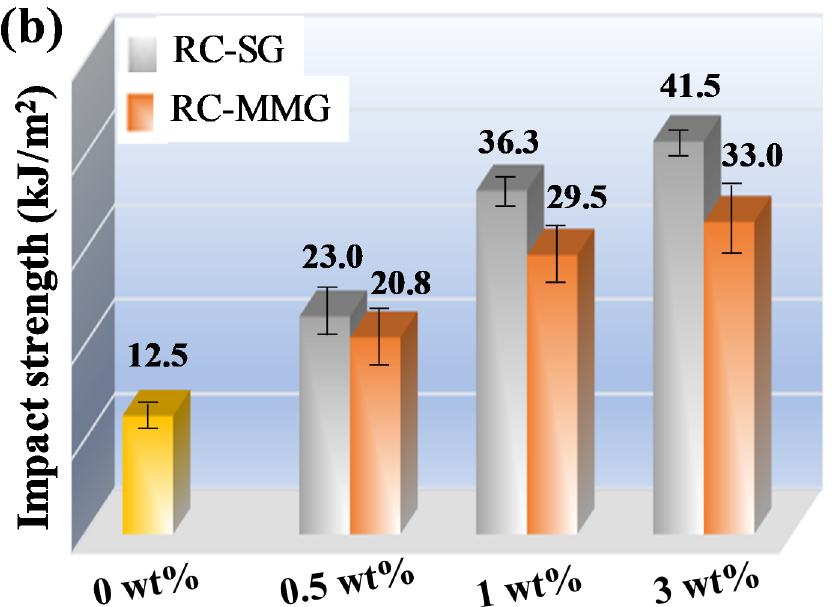
Figure 5. ( a ) Stress-elongation curves and ( b ) impact strength of PVDF / PLLA (50 / 50, w / w) blends with various contents of RC–SG or RC–MMG.